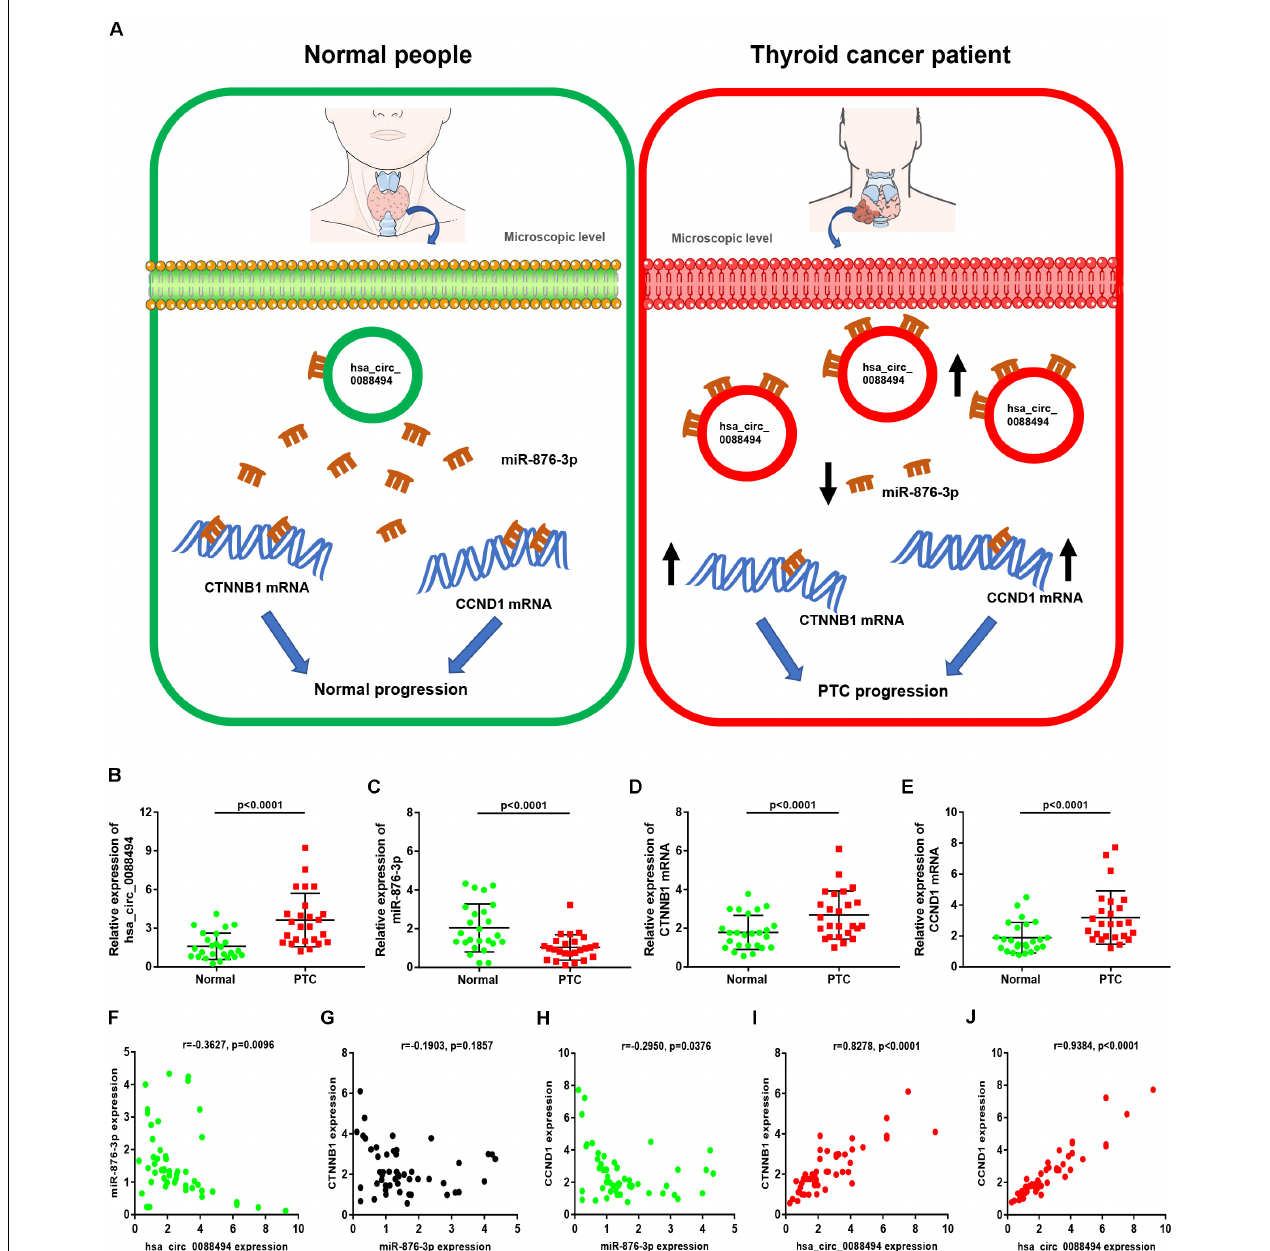
FIGURE 8 | Construction and validation of a potential axis (hsa_circ_0088494-miR-876-3p-CTNNB1/CCND1) involved in progression of thyroid carcinoma. (A) The model of hsa_circ_0088494-miR-876-3p-CTNNB1/CCND1 axis in PTC. (B) Hsa_circ_0088494 expression in 25 pairs PTC and adjacent normal tissues. (C) MiR-876-3p expression in 25 pairs PTC and adjacent normal tissues. (D) CTNNB1 mRNA expression in 25 pairs PTC and adjacent normal tissues. (E) CCND1 mRNA expression in 25 pairs PTC and adjacent normal tissues. (F) Expression correlation of hsa_circ_0088494 with miR-876-3p in PTC. (G) Expression correlation of CTNNB1 with miR-876-3p in PTC. (H) Expression correlation of CCND1 with miR-876-3p in PTC. (I) Expression correlation of hsa_circ_0088494 with CTNNB1 in PTC. (J) Expression correlation of hsa_circ_0088494 with CCND1 in PTC. “ p < 0.05” was considered as statistically